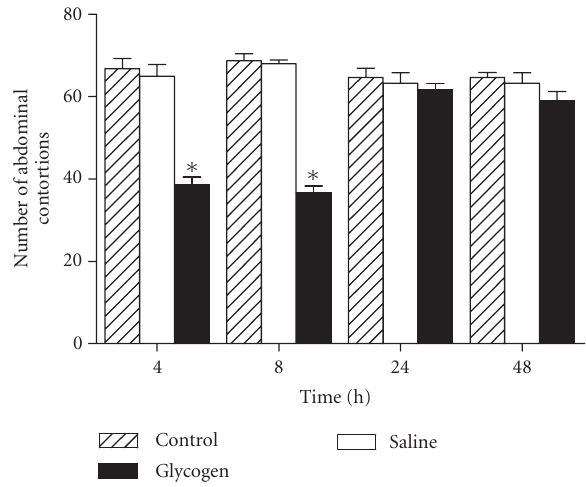
Figure 2: E ff ect of glycogen on painful sensibility of mice evaluated in the writhing test. The test was applied in di ff erent times after IP injection of glycogen (5%, 500 μ L/animal). Controls were injected only with acetic acid. Values represent the mean imals for each group. (cid:0) P < . 05 in comparison with values obtained in control